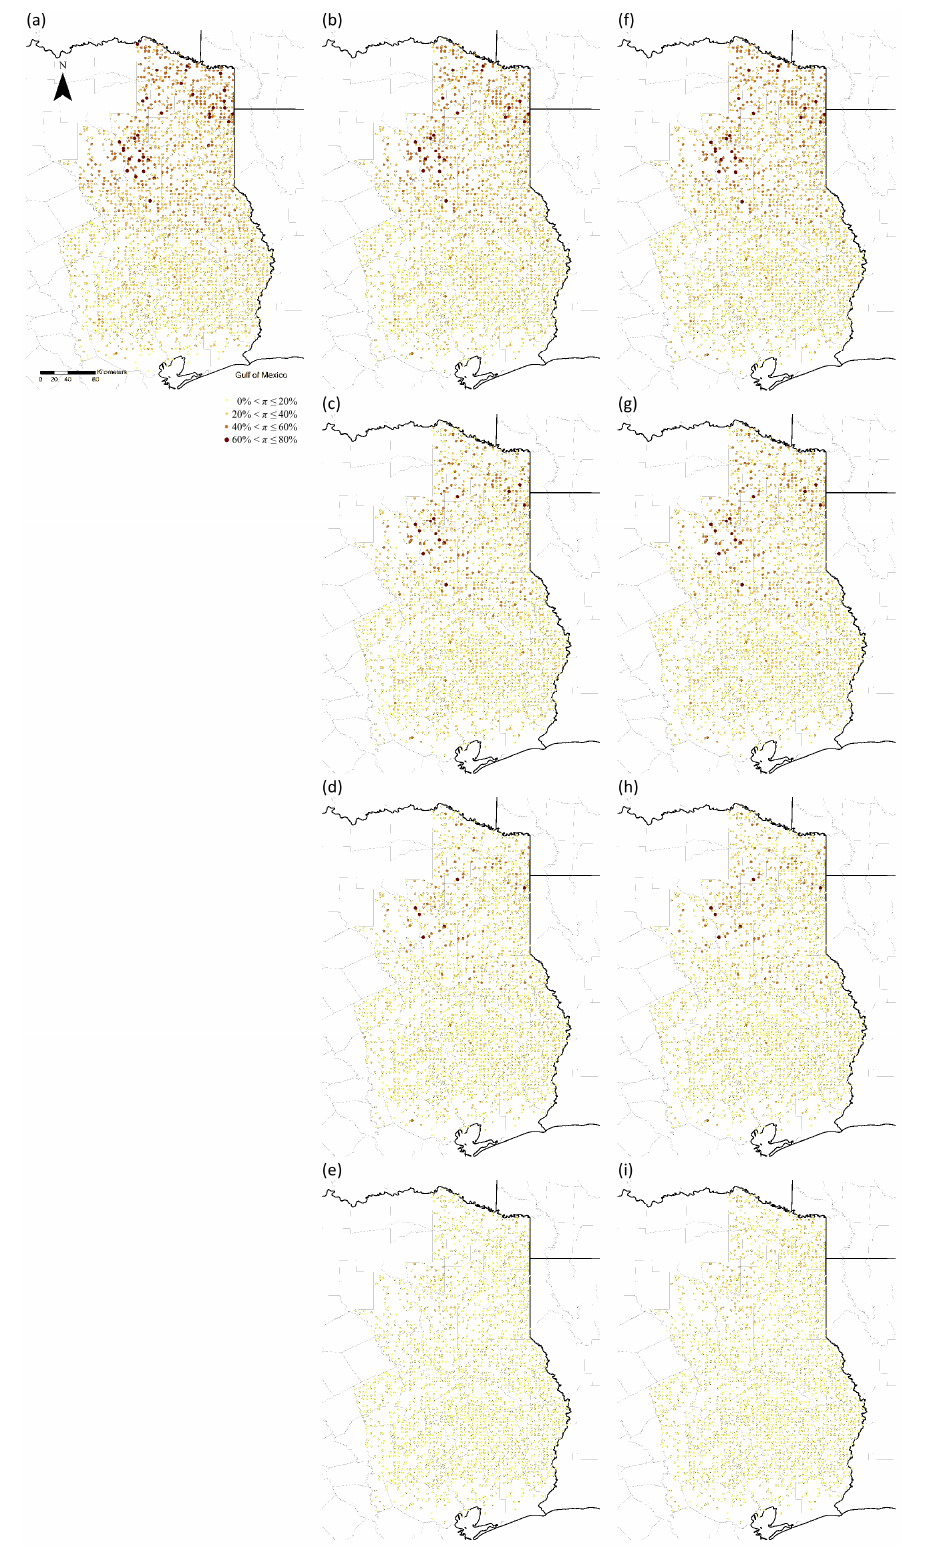
Figure 3. Estimated probabilities of further invasion by Chinese privet in plots sampled in Eastern Texas as part of the Forest Inventory and Analysis Program of the U.S. Forest Service assuming ( a ) current conditions; ( b ) site preparation on 25%; ( c ) 50%, ( d ) 75%; or ( e ) 100% of the plots (chosen at random); and ( f ) artificial regeneration on 25%; ( g ) 50%; ( h ) 75%; or ( i ) 100% of the